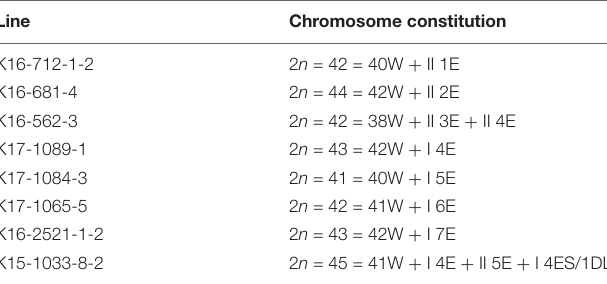
TABLE 4 | Chromosome constitution of eight hybrid